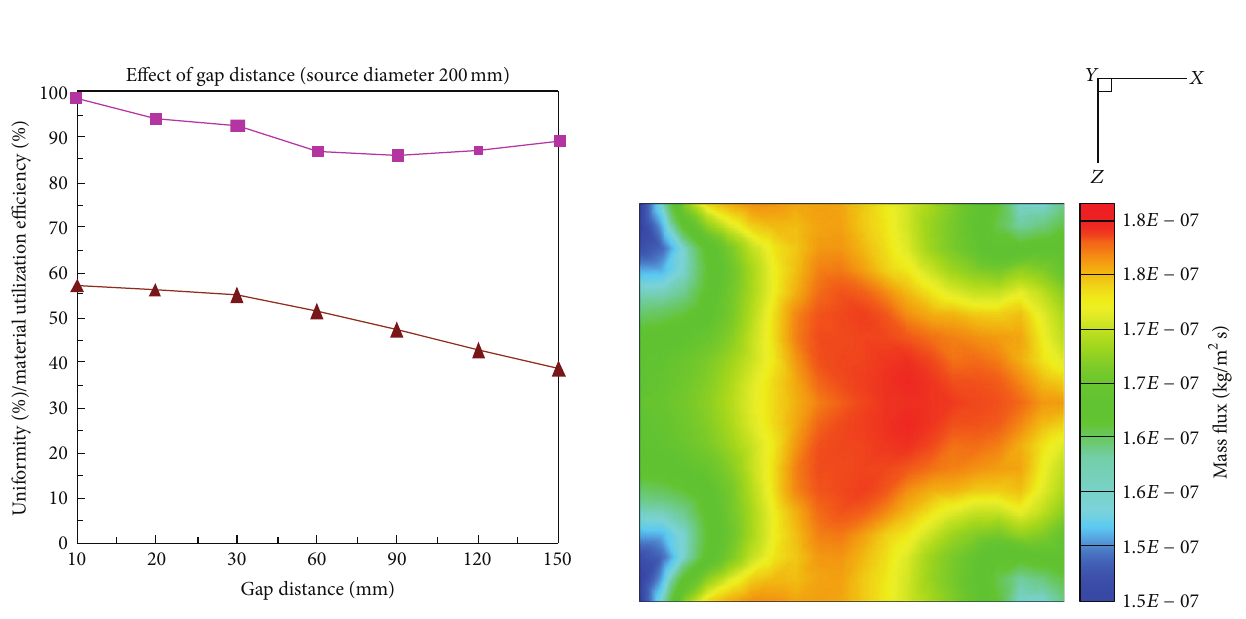
Figure 7: Mass flux of Organic Material A. Luminance, chromaticity, and electroluminescence spec- tra of the OLEDs were recorded using a PR-650 Spec- traScan Colorimeter. The current-voltage characteristics were measured using a Keithley 2400 source meter. All of the measurements were performed at room temperature in